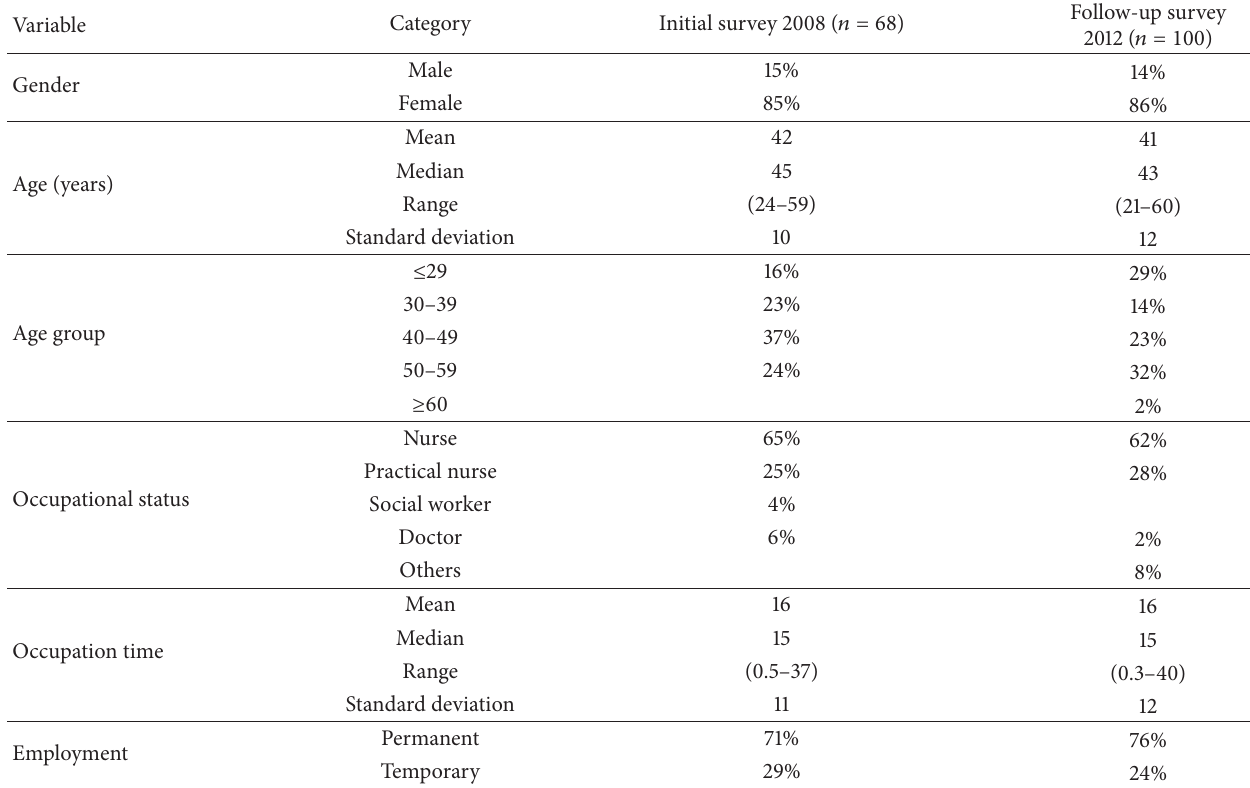
Table 1: Demographic data on